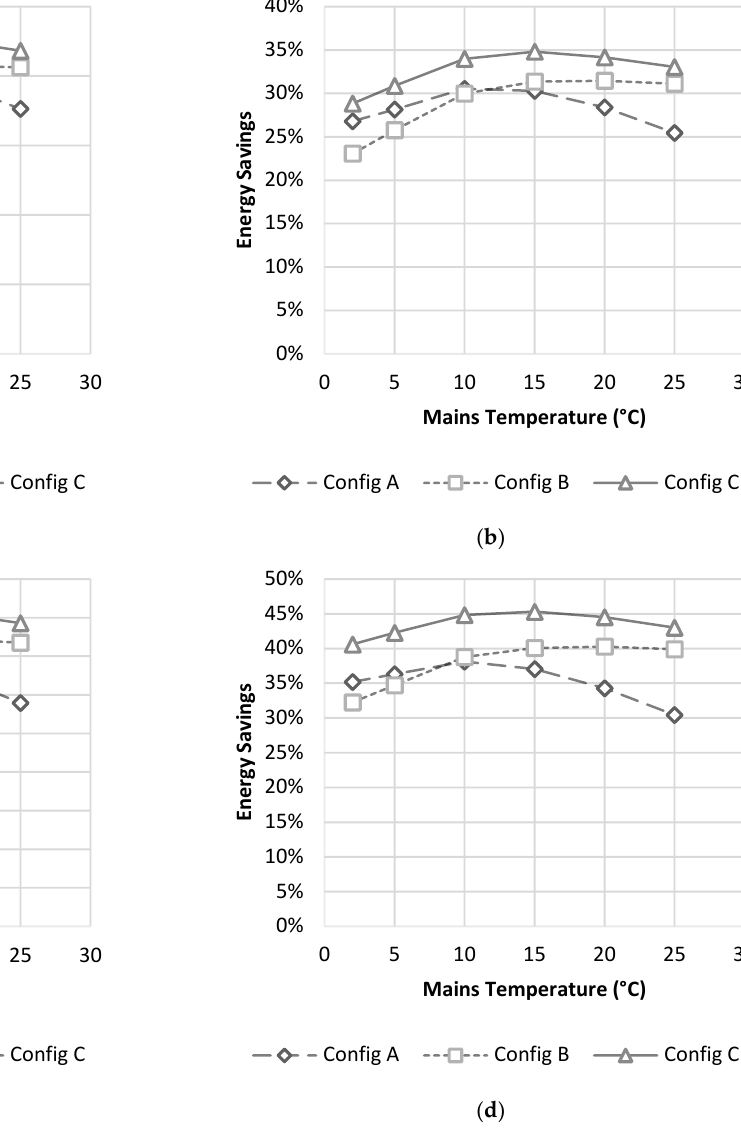
Figure 6. Energy savings as a function of mains temperature for a showerhead flowrate of 14 L/min for configurations A, B and C, as labelled. The plots correspond to heat exchanger 1 ( a ), heat exchanger 2 ( b ), heat exchanger 3 ( c ), and heat exchanger 4 ( d ).